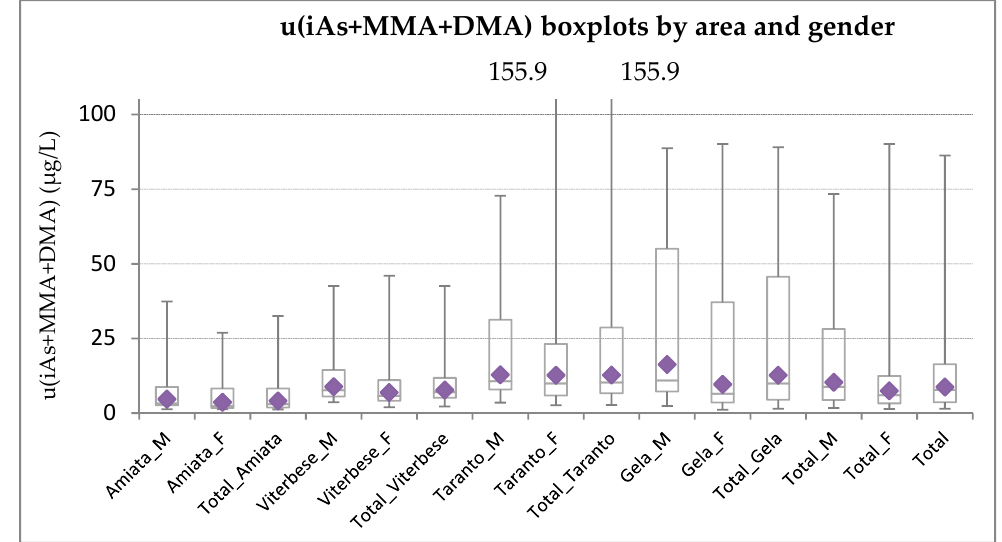
Figure 1. Distribution of u(iAs+MMA+DMA) (µg/L) by area and gender. Notes: Diamonds represent the GM; upper whiskers represent 95th percentile. Table 2. Descriptive analysis on u(iAs+MMA+DMA) (µg/L) by area and gender.